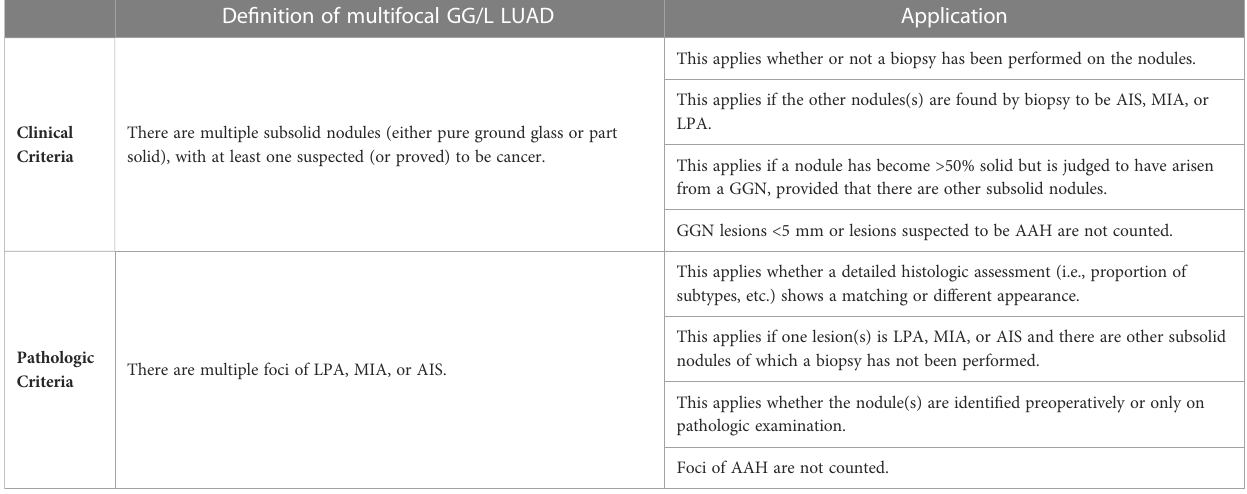
TABLE 1 Multifocal ground glass/lepidic lung adenocarcinoma diagnosis criteria according to the 8th edition of TNM classi fi cation. De fi nition of multifocal GG/L